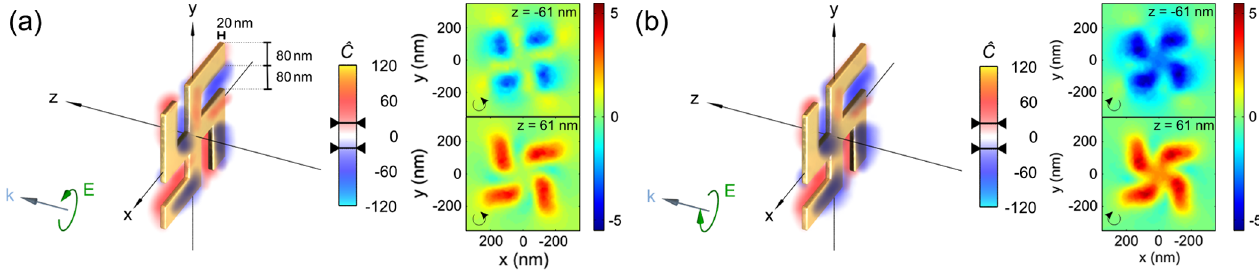
FIG. 4. Optical chirality enhancement by a planar gammadion structure illuminated with (a) LCP and (b) RCP at a wavelength of 2 : 01 (cid:1) m . The structure exhibits similar shapes for the regions with enhanced chirality for both polarizations; only the values differ (as best seen in the two-dimensional slice views).